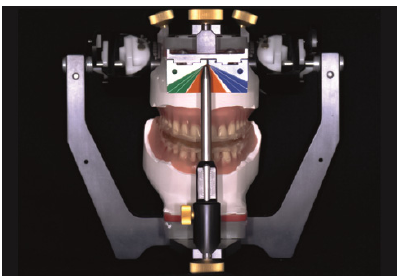
Figure 5. Models mounted on articulator in ThP after splint therapy: frontal view.